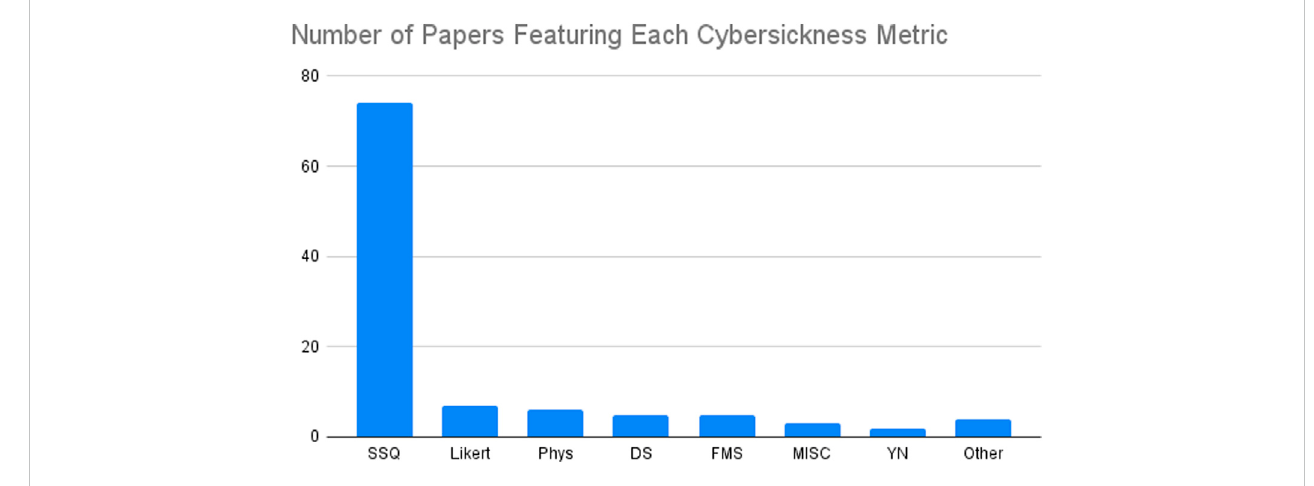
FIGURE 6 The number of papers featuring each cybersickness measurement